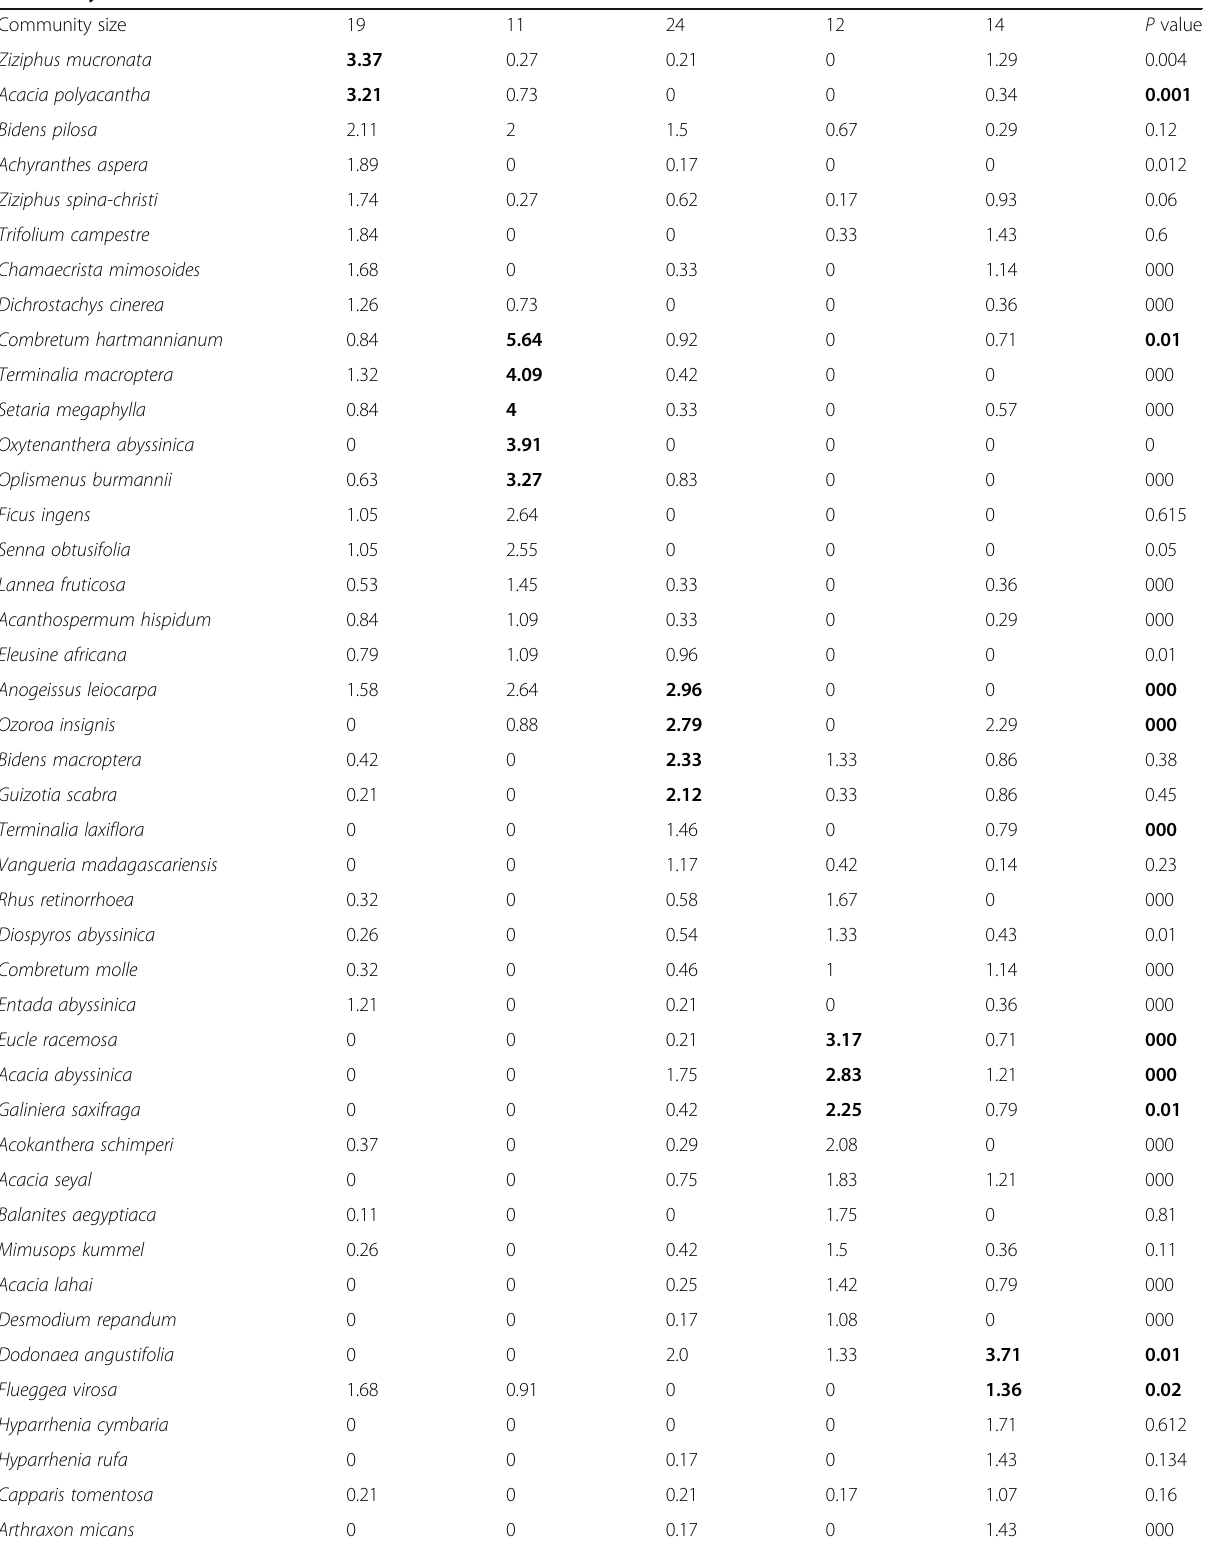
Table 2 Species list with synoptic cover-abundance values for species having a value of ≥ 1 at least one in a community type Community